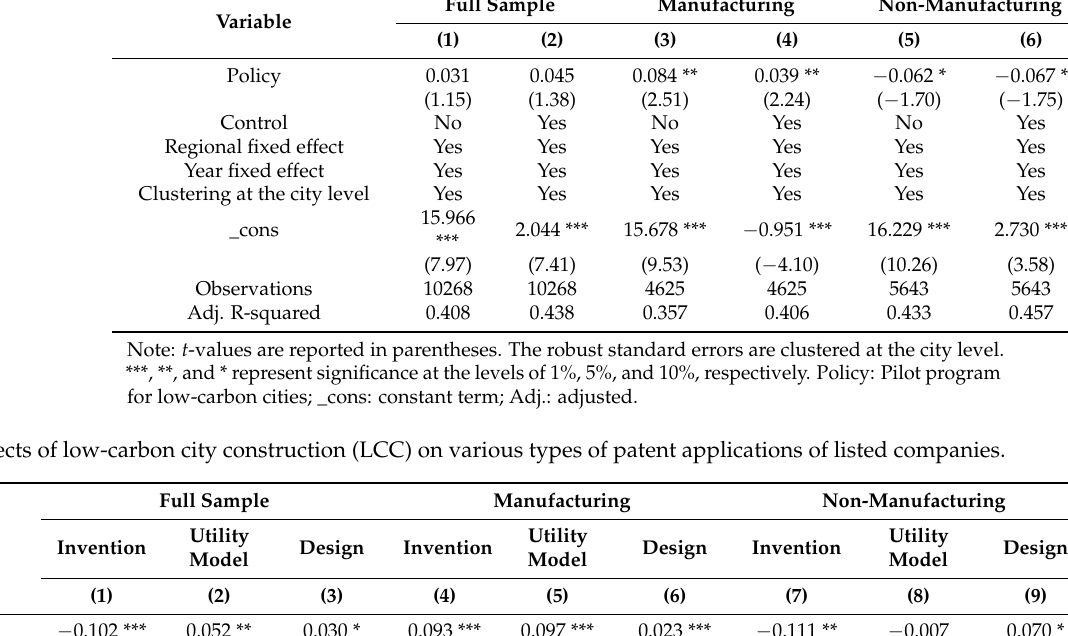
Table 12. Effects of low-carbon city construction (LCC) on research and development (R&D) expen- ditures of listed companies.